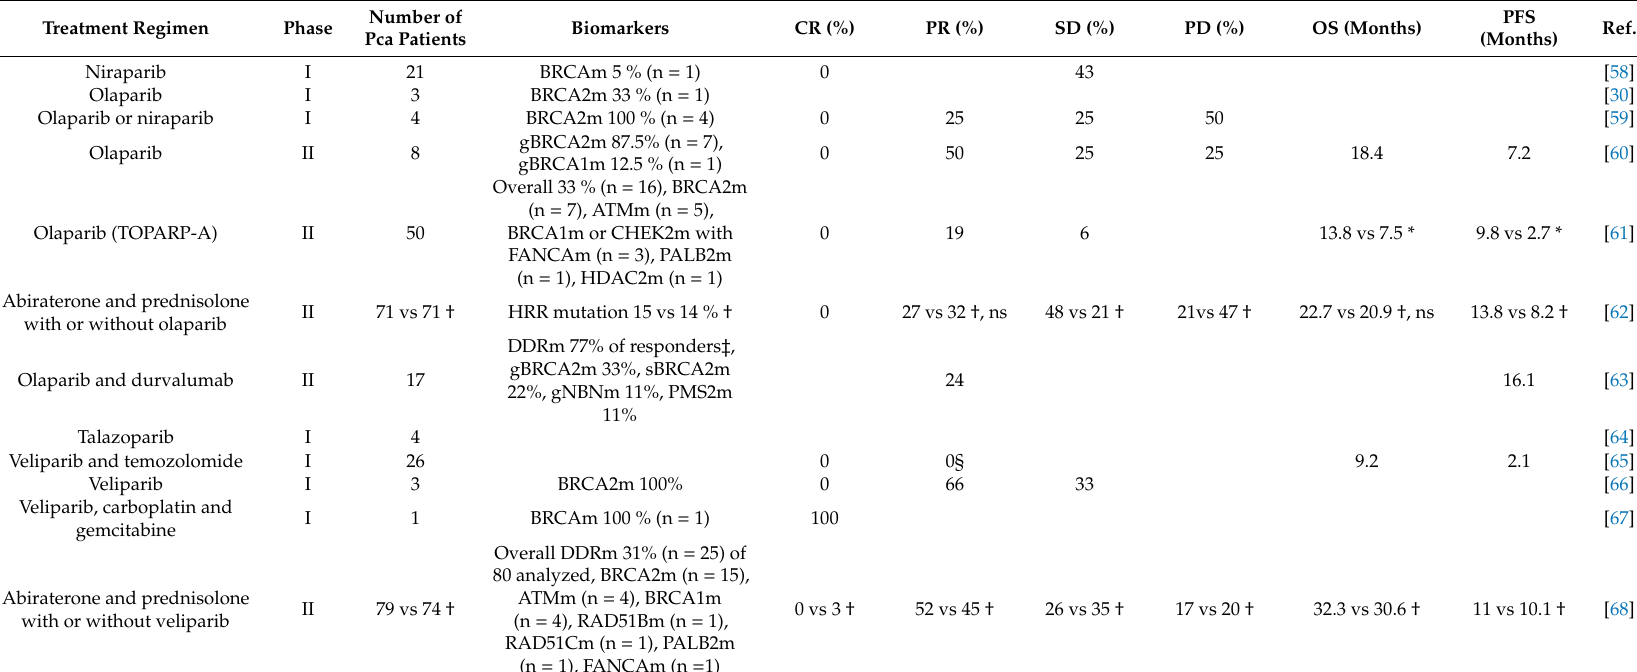
Table 2. E ffi cacy results of PARP inhibitor treatment in prostate